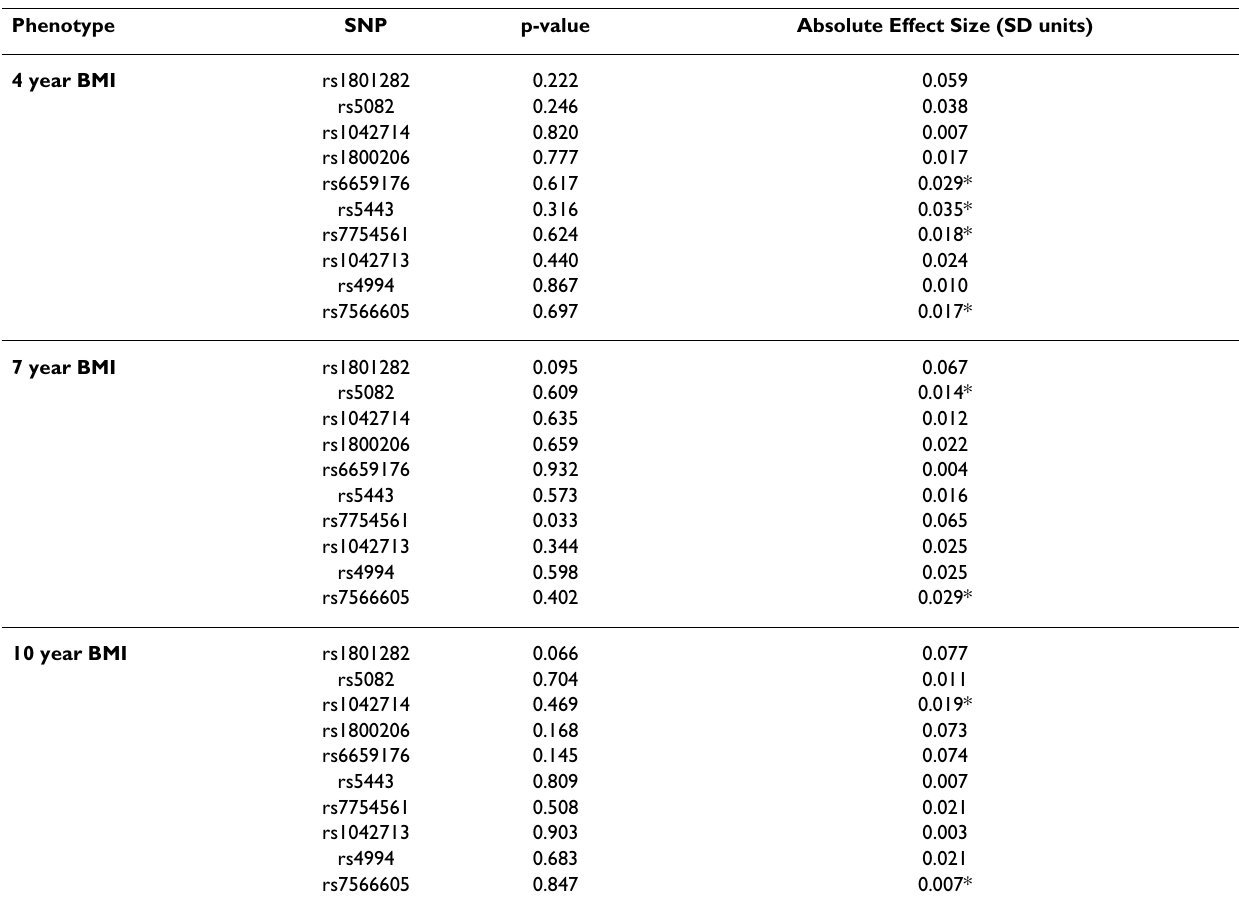
Table 3: Results from QTDT for BMI z-scores at 4, 7 and 10 years